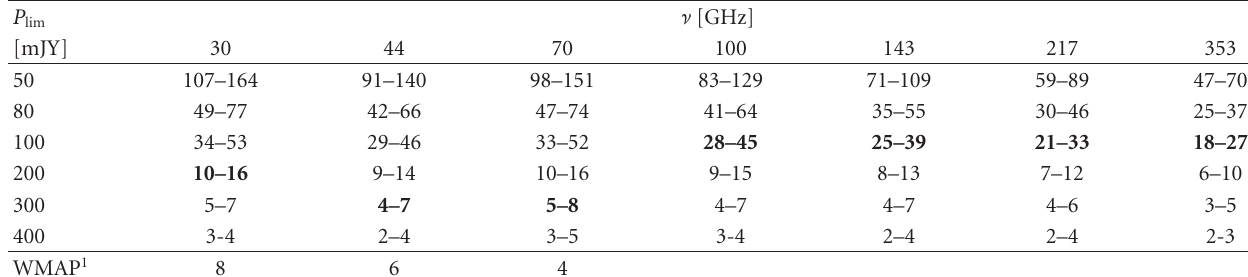
Table 5: Expected total numbers of ERS with polarized intensity ≥ P lim over the full sky at Planck frequencies. For each Planck channel, the minimum and maximum values here indicated refer to our predictions calculated by the more “optimistic” and by the more “conservative” cases previously discussed (see Table